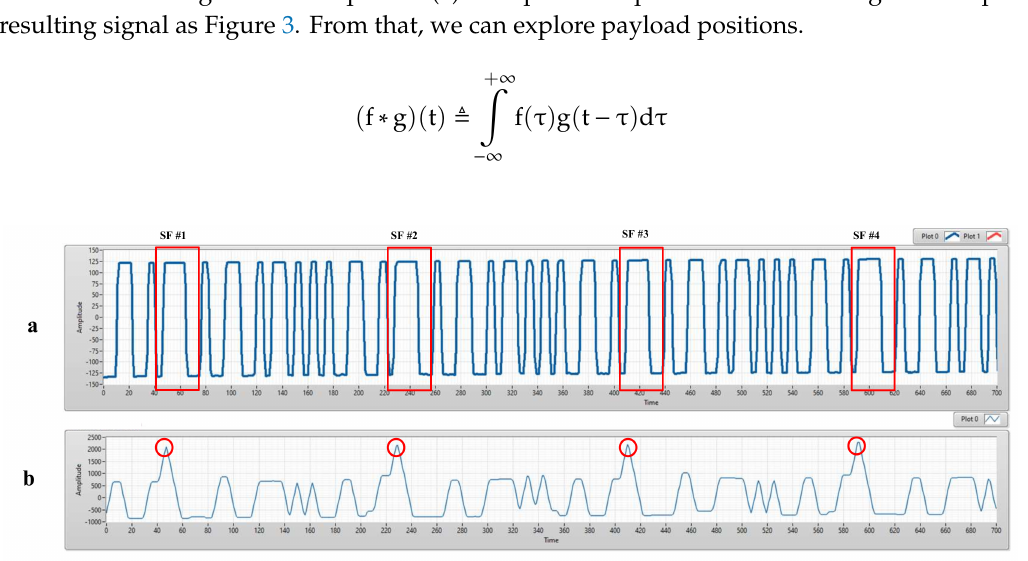
Figure 3. ( a ) An experimental result of COOK within a rolling image. ( b ) The results of preamble position detection based on matched filter.